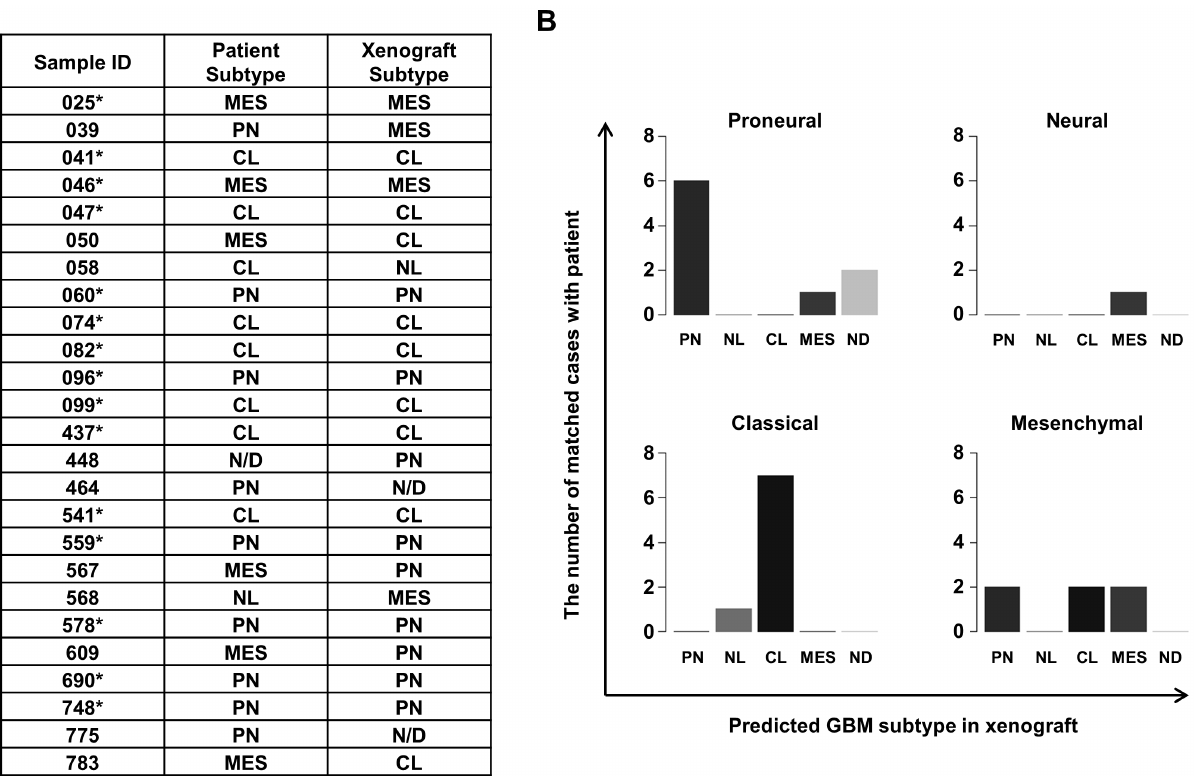
Figure 4. Orthotopic xenograft ‘‘AVATAR’’ models recapitulate the subtypes of their parental GBMs. ( A ) Predicted molecular subtypes of 25 GBM patients from the SMC GBM dataset and corresponding orthotopic xenograft ‘‘AVATAR’’ models were summarized. *, matched case. PN=Proneural, NL=Neural, CL=Classical, MES=Mesenchymal, ND=not-determined. ( B ) Subtype classification of 25 GBM patients by the NTP methods was compared with subtypes of corresponding orthotopic xenograft ‘‘AVATAR’’ models.